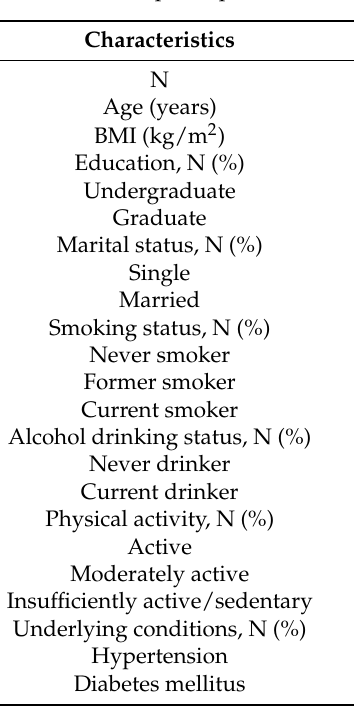
Table 1. Baseline participant characteristics by PMS group.